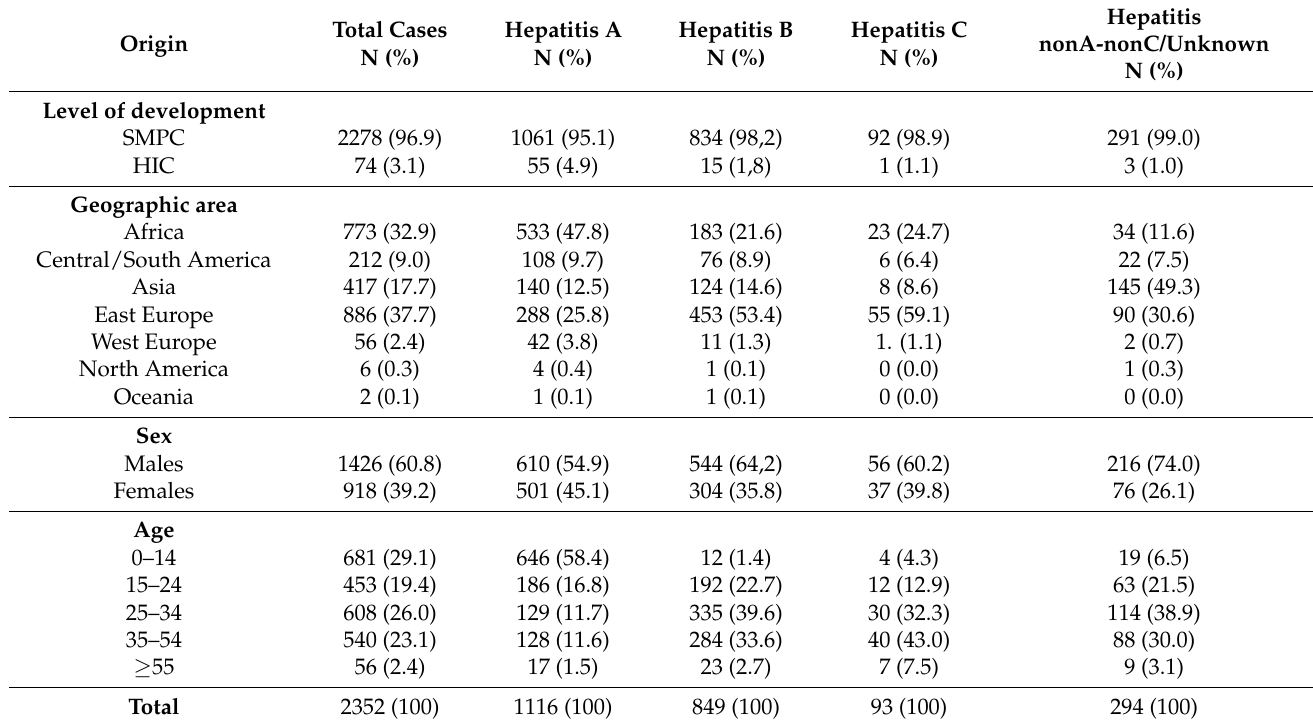
Table 2. Distribution of acute viral hepatitis cases among foreign citizens by country of citizenship (level of development and geographic area), sex, age and type of hepatitis. SEIEVA